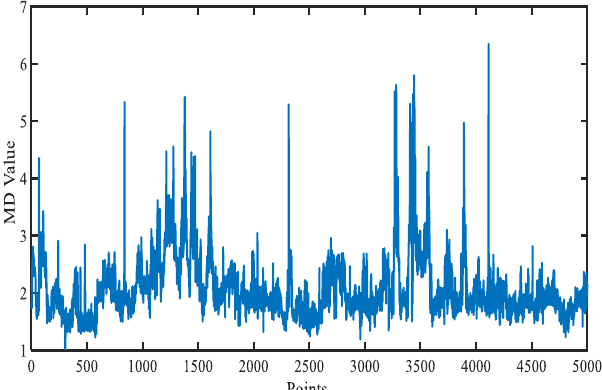
Figure 17. Actual temperature of the gearbox bearing gained from the SCADA model. Figure 18. Predicted temperature of the gearbox bearing gained from the LSTM model.